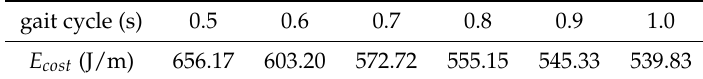
Figure 16. The energy consumptions with different gait cycle. Table 7. E cost with different gait